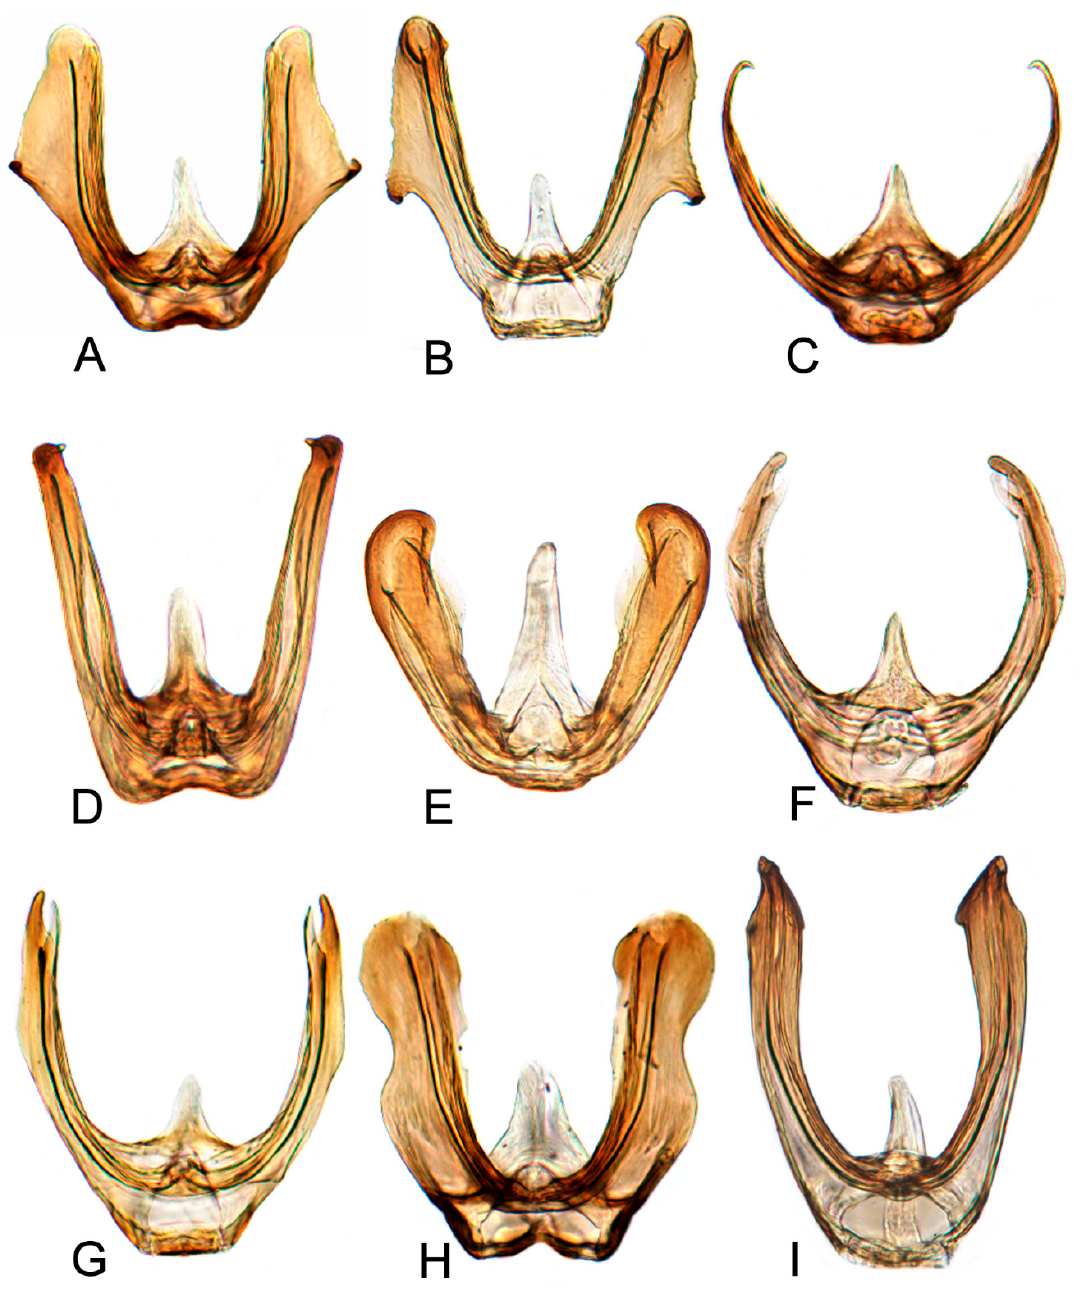
Figure 19. Aedeagus, posterior view. ( A ) H. viraktamathiellus ; ( B ) H. triangulus ; ( C ) H. concavus ; ( D ) H. dietrichi ; ( E ) H. bucephalus ; ( F ) H. fletcheri ; ( G ) H. dichotomous ; ( H ) H. sellatus ; and ( I ) H. rectus .